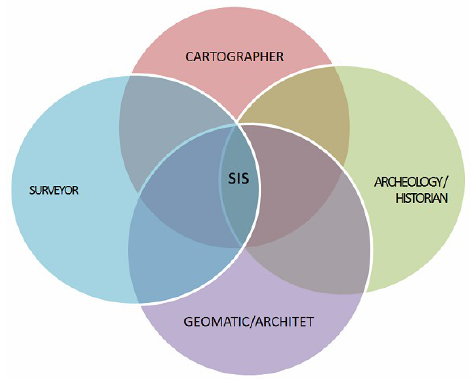
Figure 6. Skills for the construction of an archaeological and Cultural Heritage